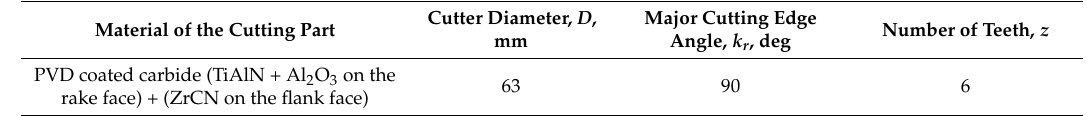
Table 2. Parameters of tools.